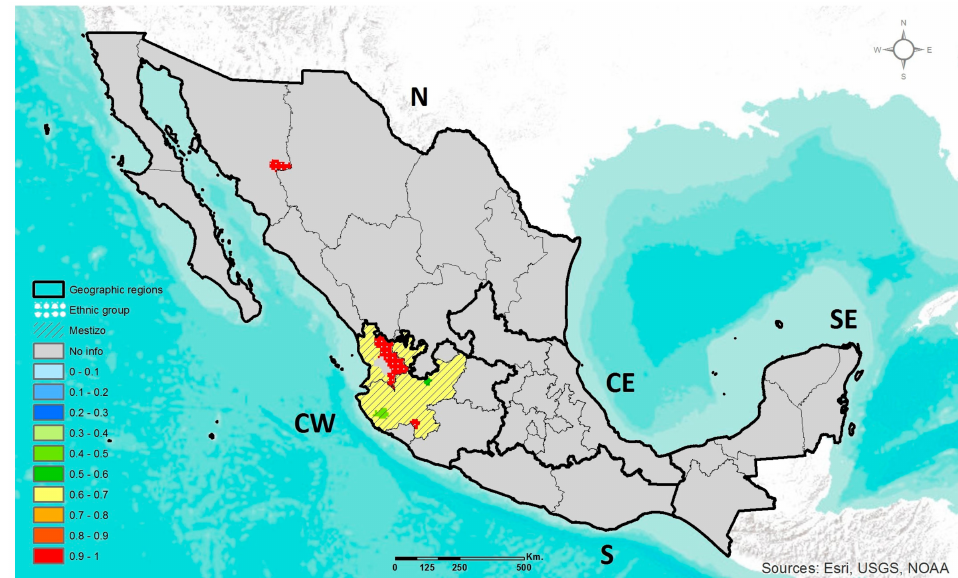
Figure 4. Geographic distribution of the LCT -13910CC genotype frequency in ethnic groups and Mestizo population of Mexico.